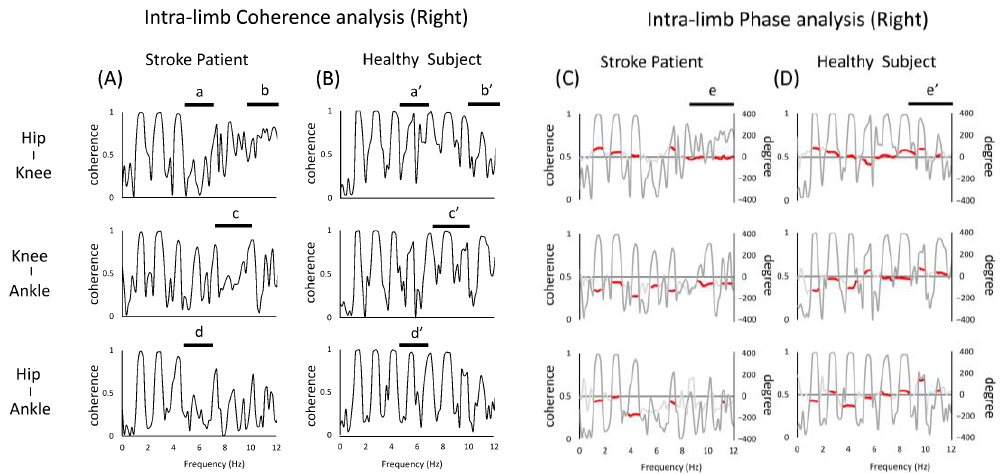
Figure 4. Diagram of the intra-limb (right limb) coherence and phase analysis of the left lower limb. The figure ( A , B ) shows the results of the coherence analysis. The figure ( C , D ) shows the results of the phase analysis overlaid with the results of the coherence analysis (gray line). When the peak coherence is greater than 0.3, the phase results are partially shown with red lines. The top, middle, and bottom rows show the joints representing the hip, knee, and ankle joint pairs, respectively. In the figure, (a,a’), (b,b’), (c,c’), (d,d’) shows coherence analysis, (e,e’) shows the different parts of the phase analysis between stroke patient and healthy subject.